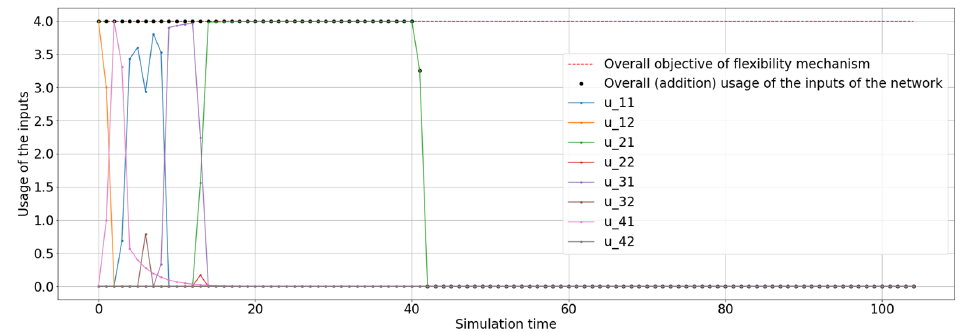
Figure 8. Solution for u-variables of the centralised MPC.